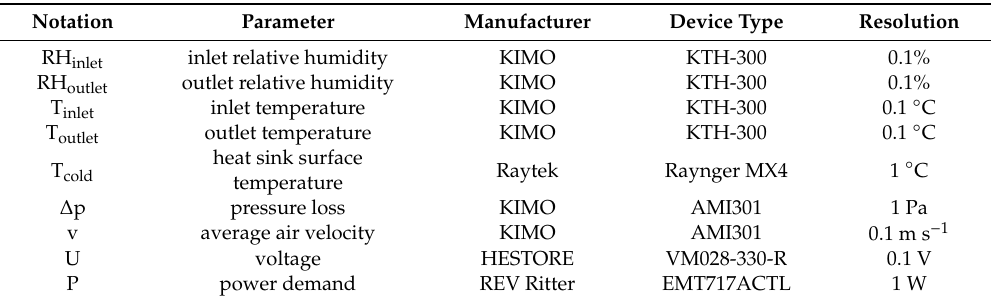
Table 3. Measured parameters.